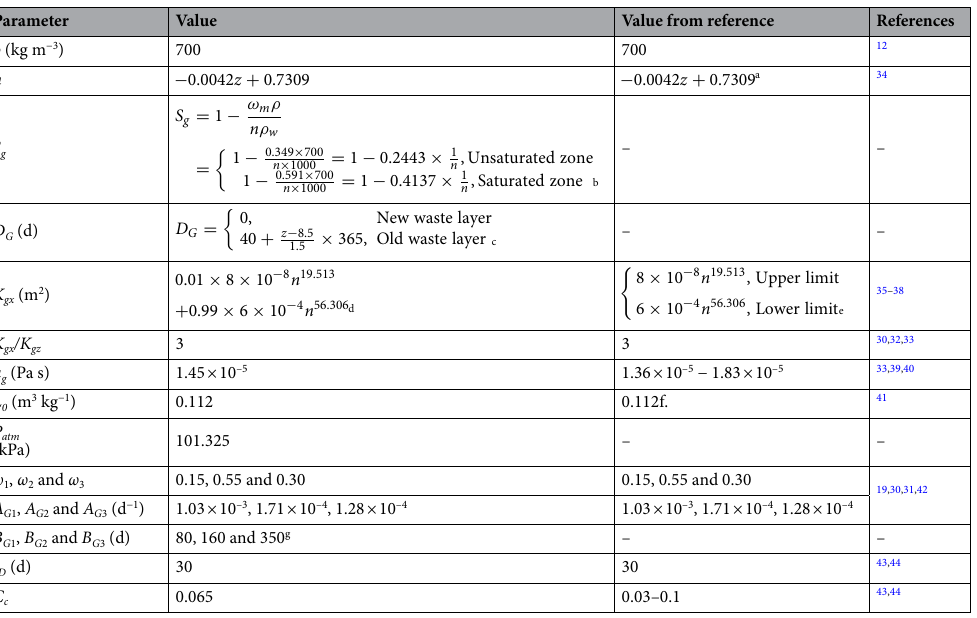
Table 1. Parameters of gas transport model in the Wuxi landfill. a n is obtained by fitting the porosity in the Suzhou landfill (about 30 km from the Wuxi landfill), where z is depth; b Where ω m is the mass moisture content of waste (the average mass moisture content in saturated and unsaturated areas are 59.1% and 34.9% 45 , respectively); ρ w is the water density; c In order to simulate the gas pressure in the monitoring well, which is placed after the waste body is excavated, the length of time that waste in the new waste layer has been degraded to produce gas is 0; 40 is the average length of time for the existence of new waste layer (d); 8.5 is the thickness of the new waste layer (m); 1.5 is the average height for placing the waste in the old waste layer each year (m); d The fitting curve through the gas permeability in the Suzhou landfill 35 is selected as the curve of gas permeability in the Wuxi landfill; e A power function was used to fit the relationship between gas permeability and porosity measured by Stoltz et al. 36 to obtain the upper and lower limits of gas permeability in landfills; f According to the statistic on the gas production potential of waste in different landfills 41 , the gas production potential of waste in the Hangzhou landfill (about 140 km from the Wuxi landfill) is found; g The settlement strain obtained from Eq. (6) is multiplied by the thickness of the new waste layer (8.59 m) to fit the settlement of the new waste layer in the test area, as is shown in Fig.